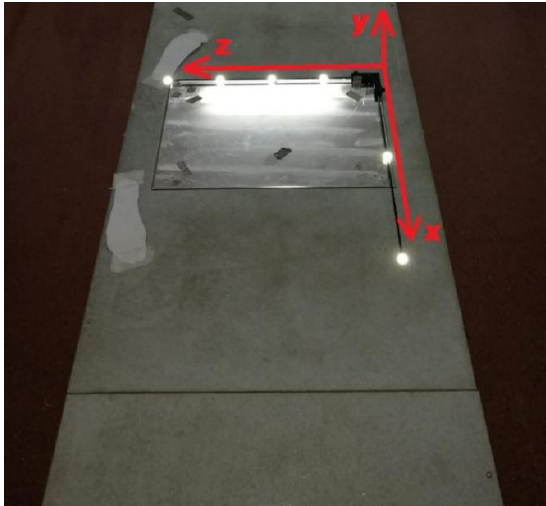
Figure 1. Experimental setup for load acquisition: wooden walkway and force plate.